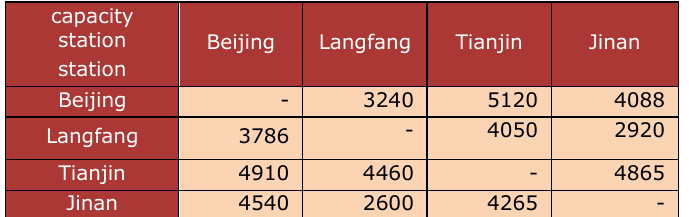
Table 5. Passenger demand forecasting